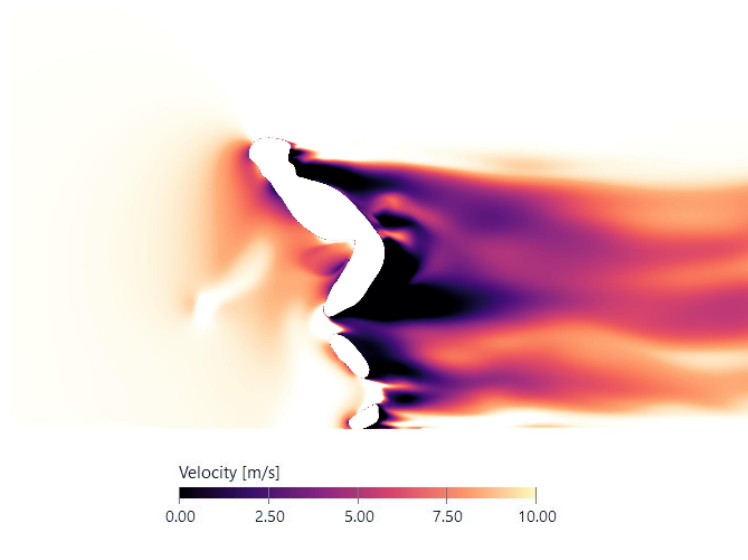
Figure 7. Flow wake for the HH position at 20° yaw; model sliced along y-